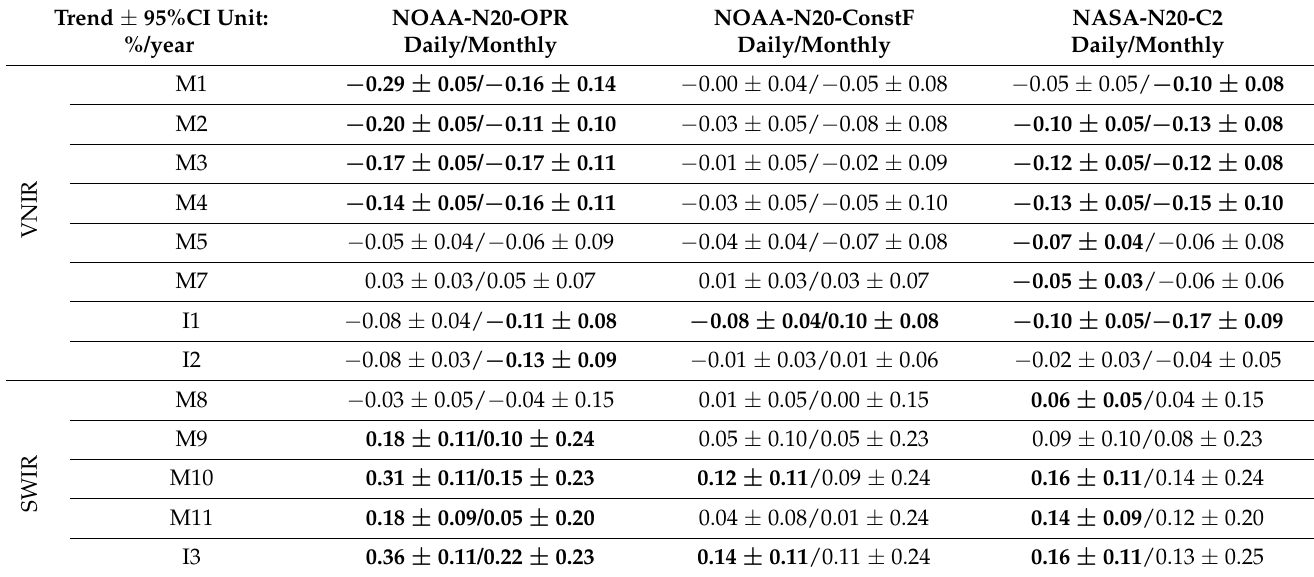
Table 4. Summary of the trends and 95% confident intervals (CI) of NOAA-20 VIIRS RSB DCC time series for the NO-AA-N20-ConstF and NASA-N20-C2 products. Cases with trends beyond the uncertainty levels are in